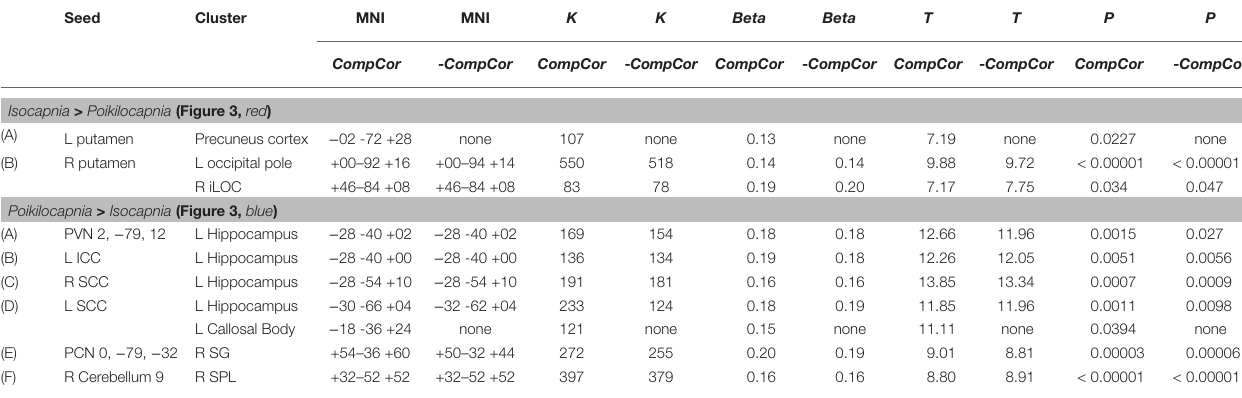
TABLE 2 | Seed-to-voxel results, brain regions showing altered functional connectivity between seed and corresponding clusters within the two different resting state condition in controls comparing with CompCor and without CompCor. Seed